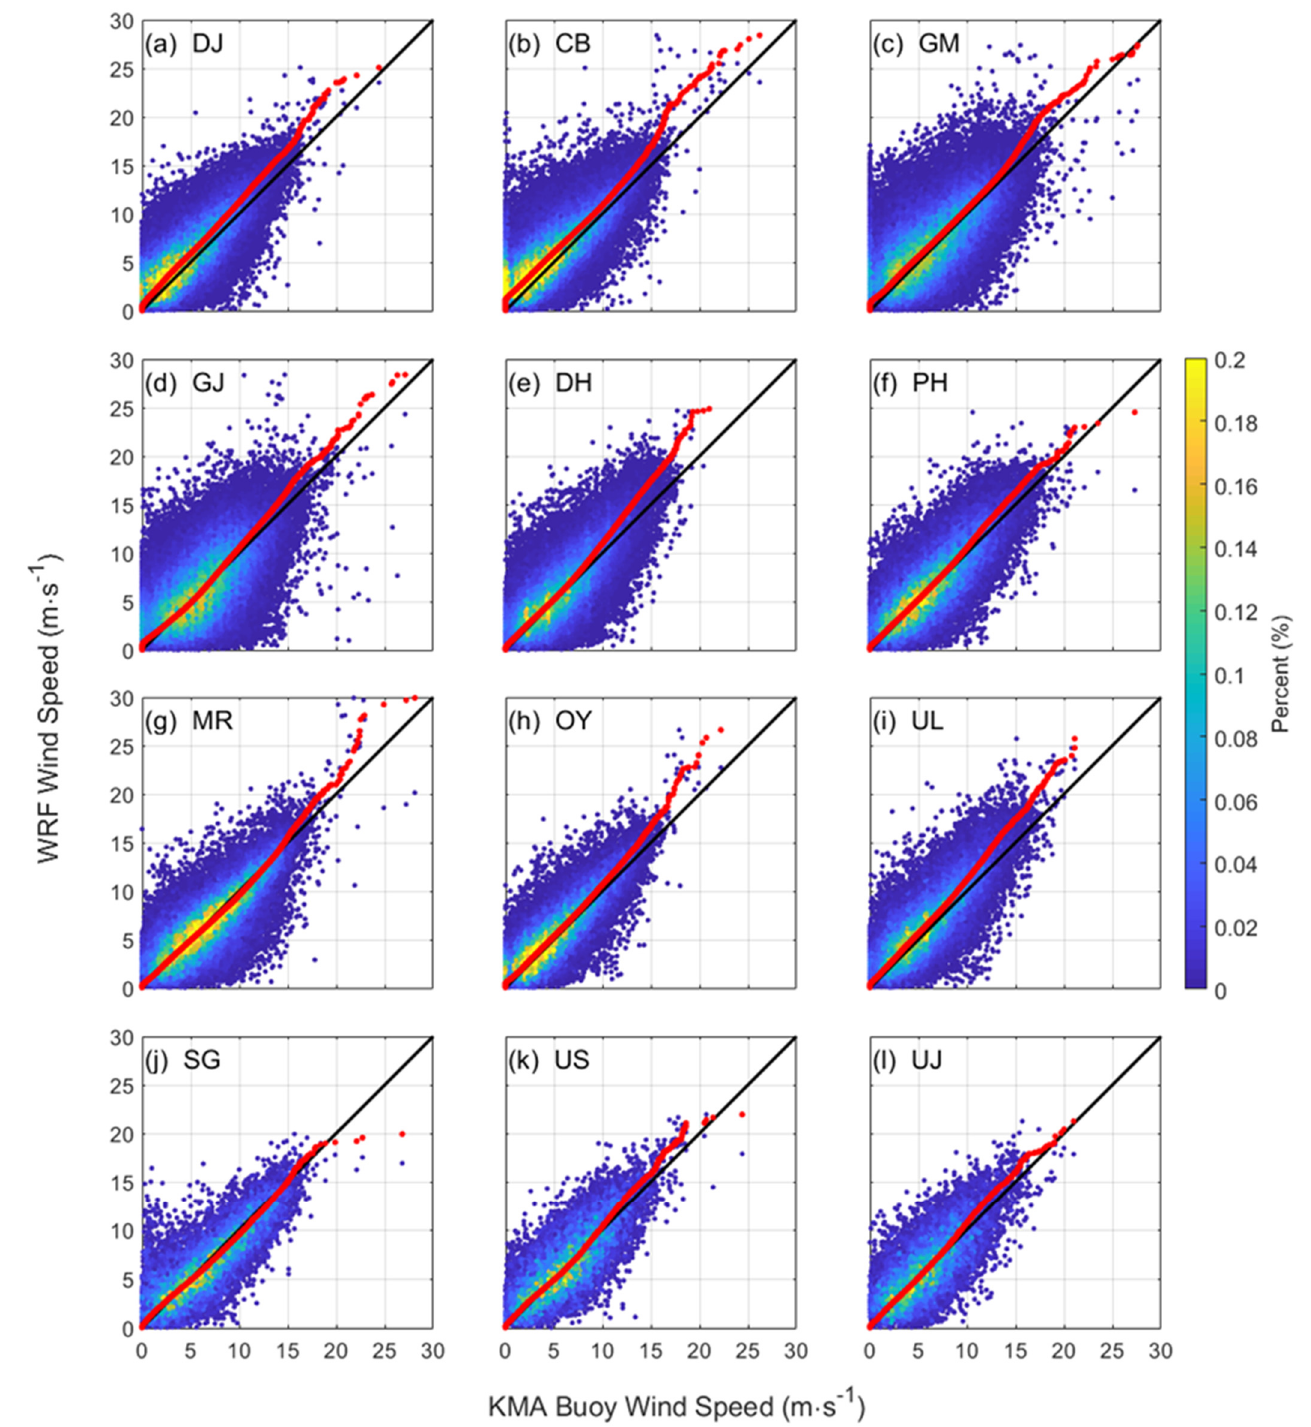
Figure 4. Scatter and quantile–quantile plots of hourly wind speed between in situ observations ( x -axis) and WRF hindcast data ( y -axis) during 1997–2017 ( a – l ). Colors indicate the percentage of data in each 100 × 100 bin and red dots represent the percentile values of the quantile–quantile plots.